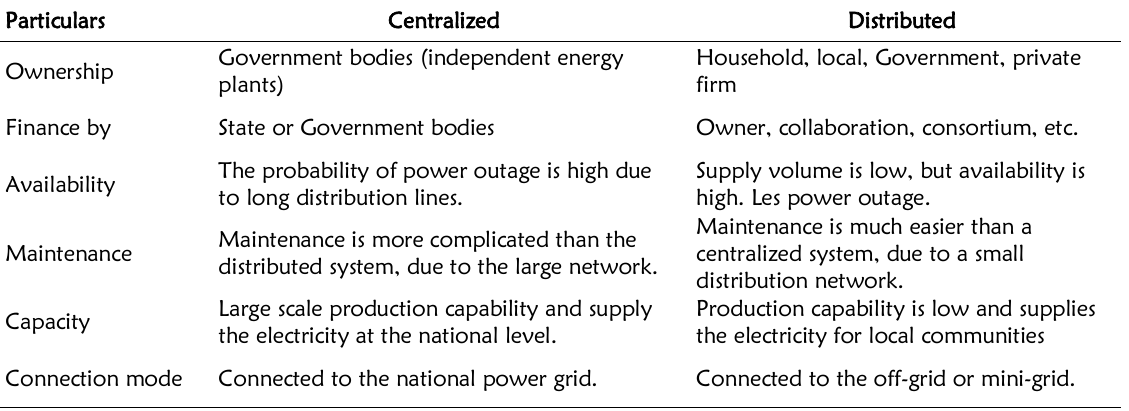
Table I: Comparison between centralized and distributed energy